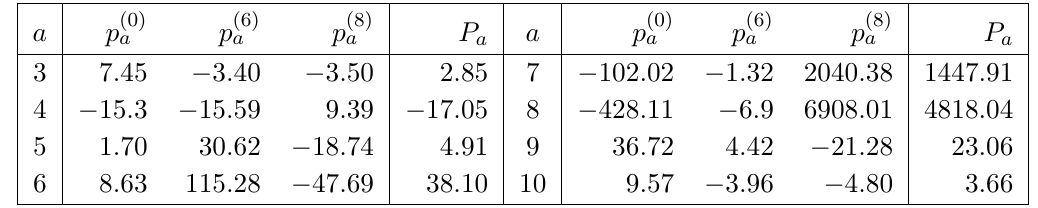
Table 5. Values of the coe(cid:14)cients entering the semi-numerical formula of " 0 =" in eq. (D.6). The last column gives P a for B (1 = 2) = 0 : 57 and B (3 = 2) = 0 : 76, the central values of these parameters 6 8 obtained in [15] from